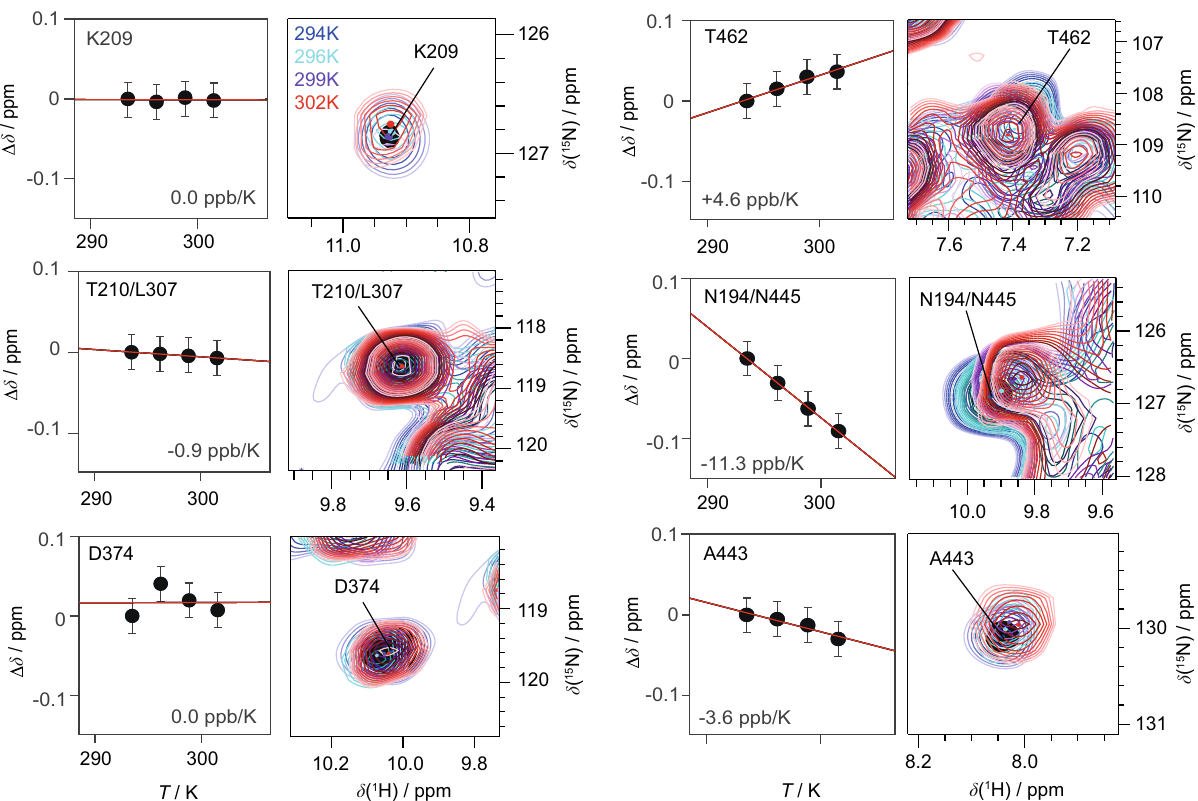
Fig. 4 Temperature-dependent proton chemical-shift values as indicators for hydrogen-bond formation. Residue-speci fi c temperature coef fi cients and corresponding temperature-dependent hNH spectra (based on two 1 H, 15 N CP steps) recorded at 20.0 T with a spinning frequency of 100 kHz for deuterated and 100% back-exchanged DnaB complexed with ADP:AlF 4 − and DNA. Temperature-dependent chemical-shift deviations (black circles) are referenced to the corresponding value at 294 K sample temperature. Chemical-shift values were extracted from n = 1 experiments and are represented as δ ± 0.05 ppm, where the shown error bar represents an estimate of the expected uncertainty within such